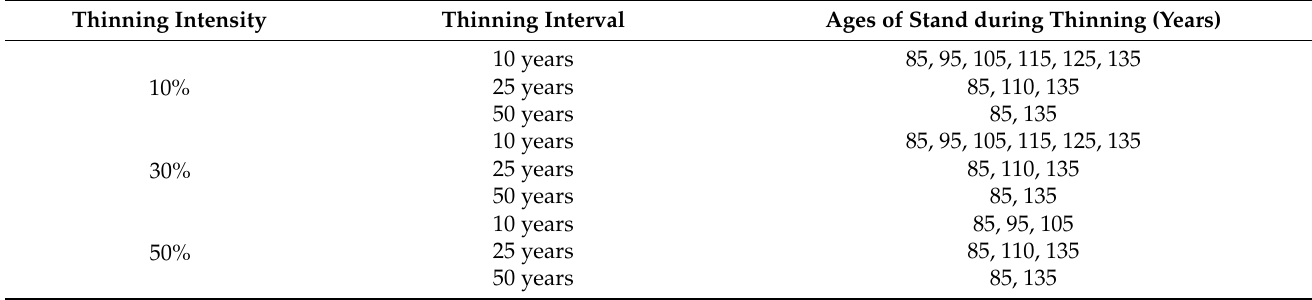
Table 1. Summary of thinning regimes.